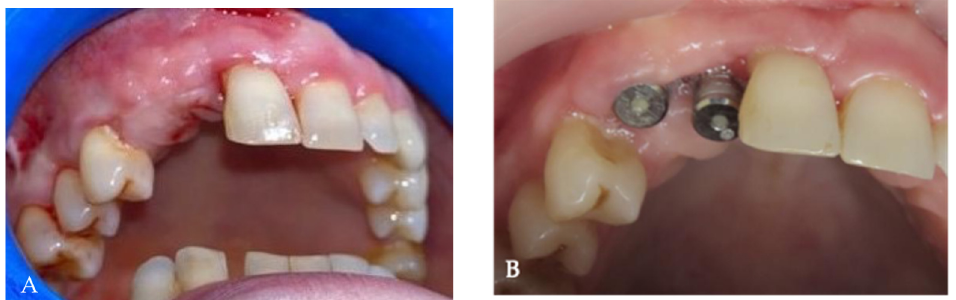
Figure 12. Intraoral images: ( A ) the aspect of gingival tissue before application of the healing abutments, ( B ) the aspect of gingival tissue after application of the healing abutments.